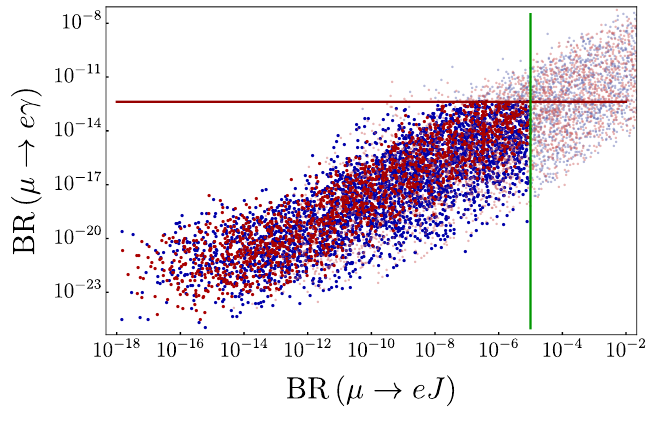
Figure 2 . BR( µ → e J ) as a function of BR( µ → e J